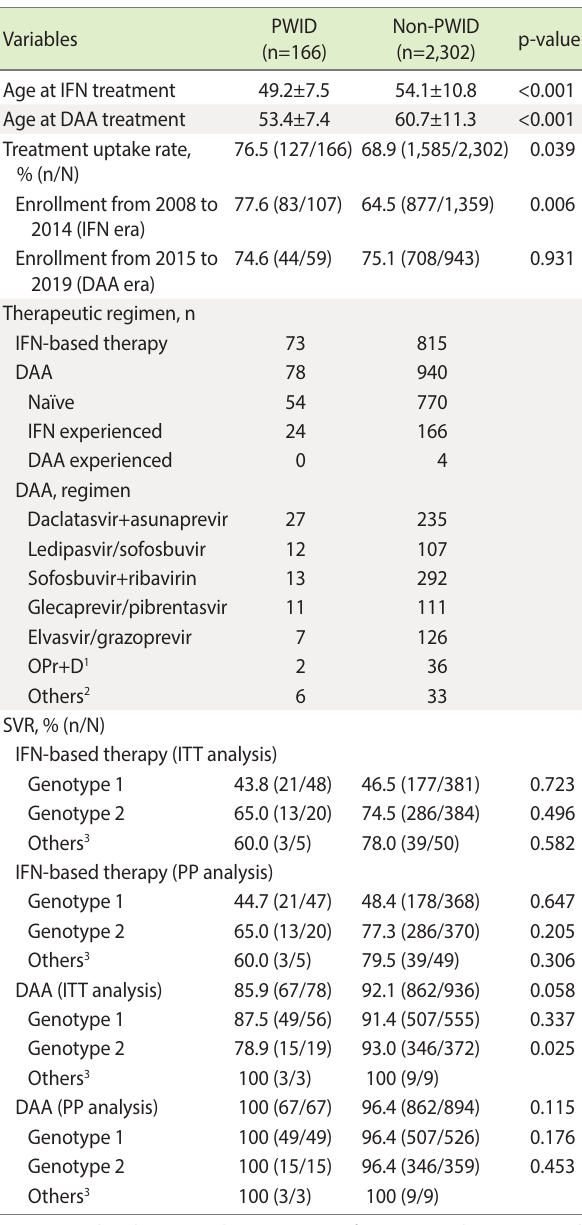
Table 4. HCV treatment uptake and outcomes according to injec- tion drug